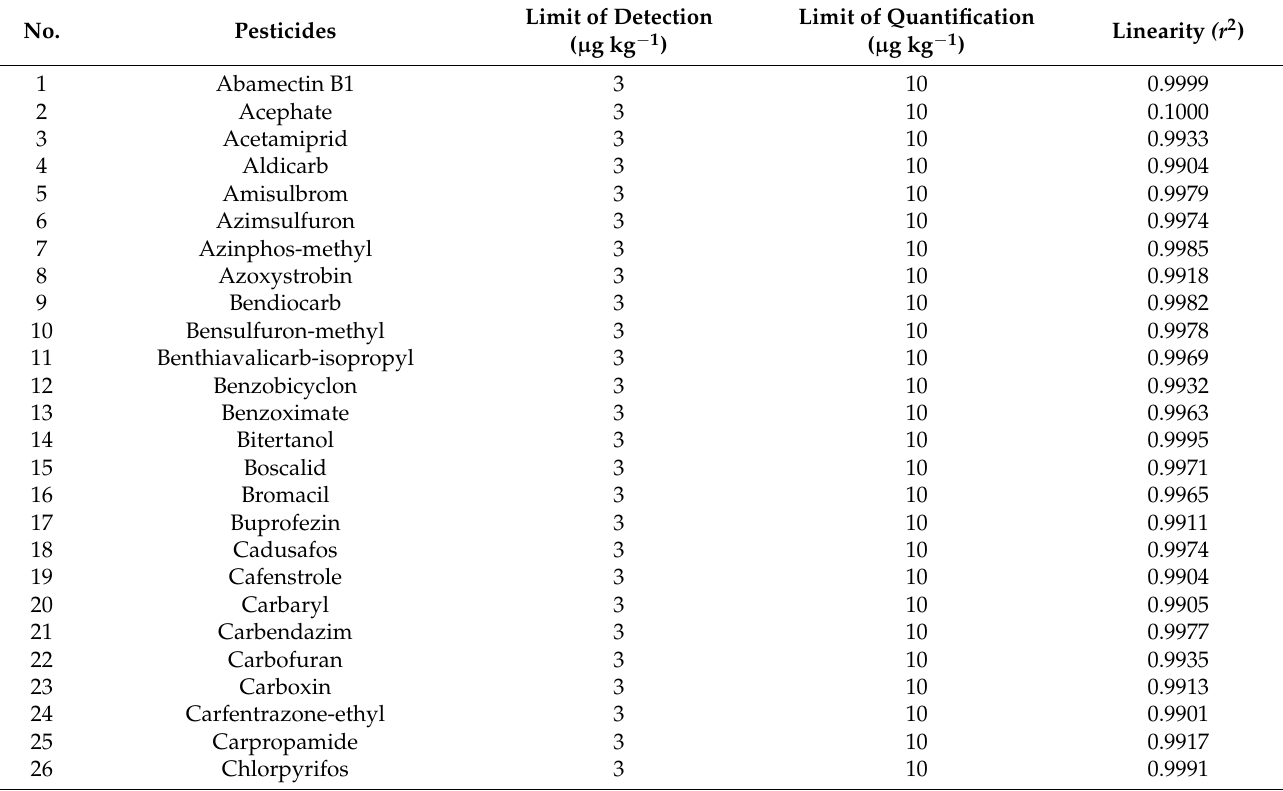
Table 4. LOD, LOQ, and linearity for the first 40 tested pesticides using LC–MS/MS. LOD, LOQ, and linearity for other 179 pesticides are listed in Table